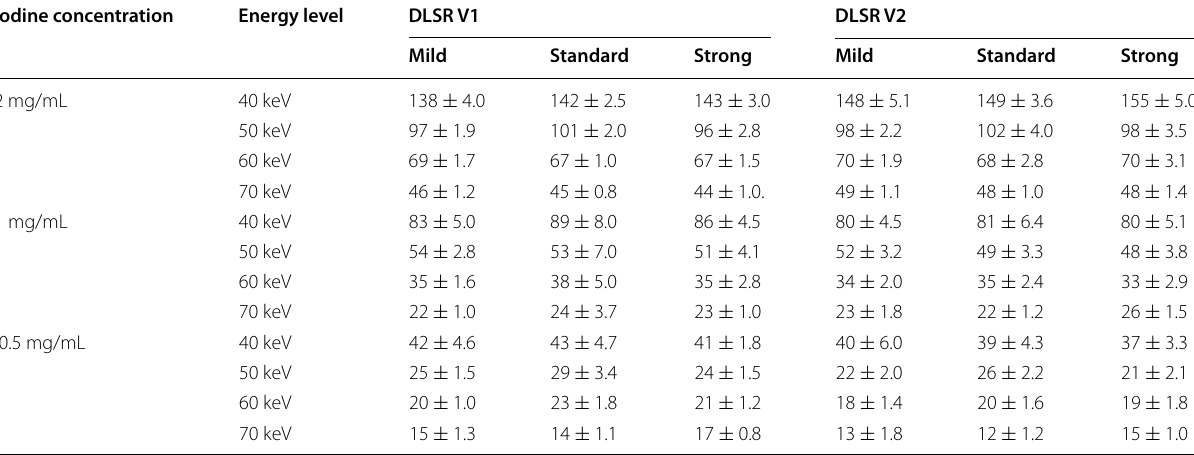
Data are given as means